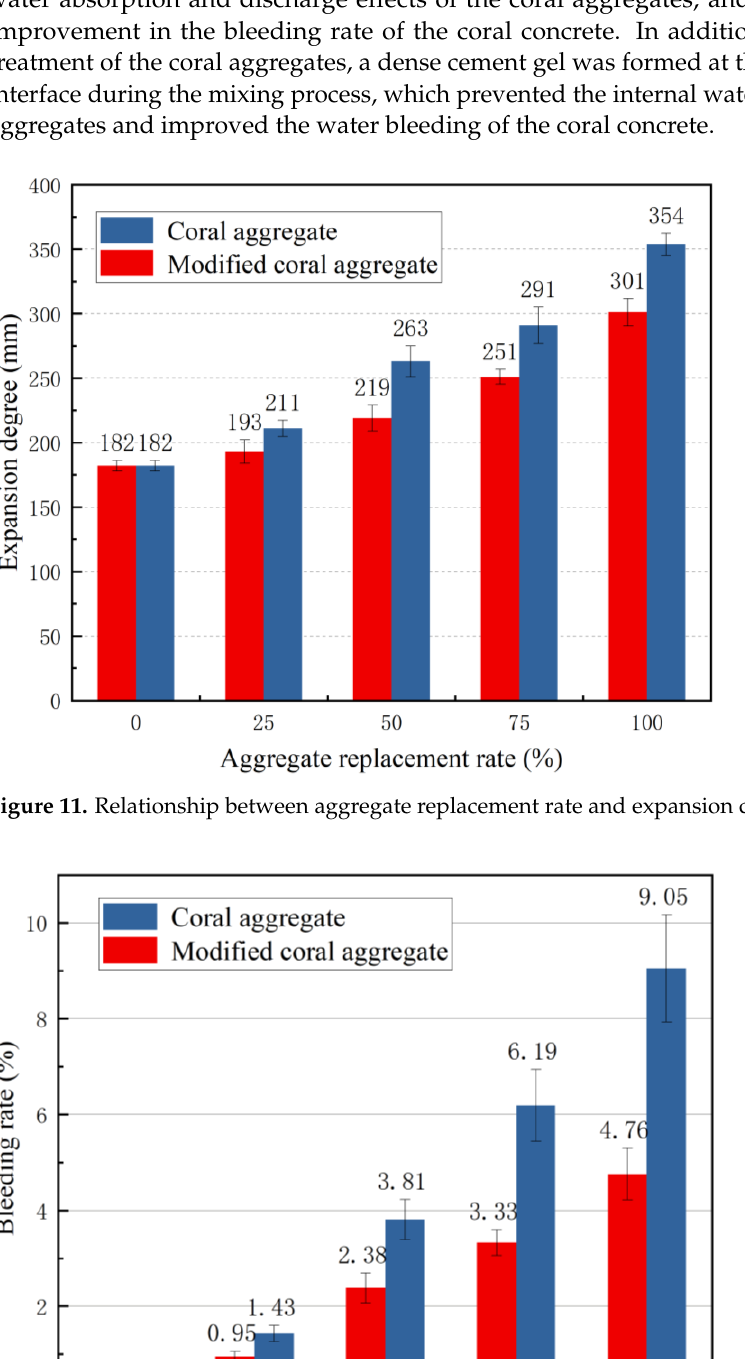
Figure 10. Relationship between aggregate replacement rate and slump.